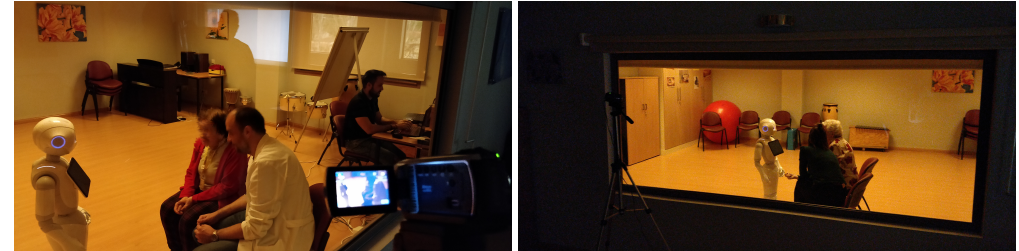
Figure 7. Images during